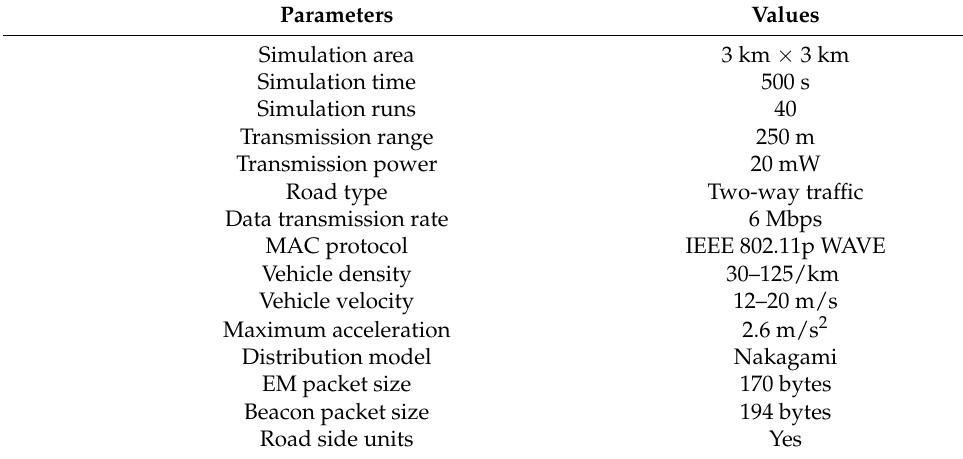
Table 2. Simulation Parameters.